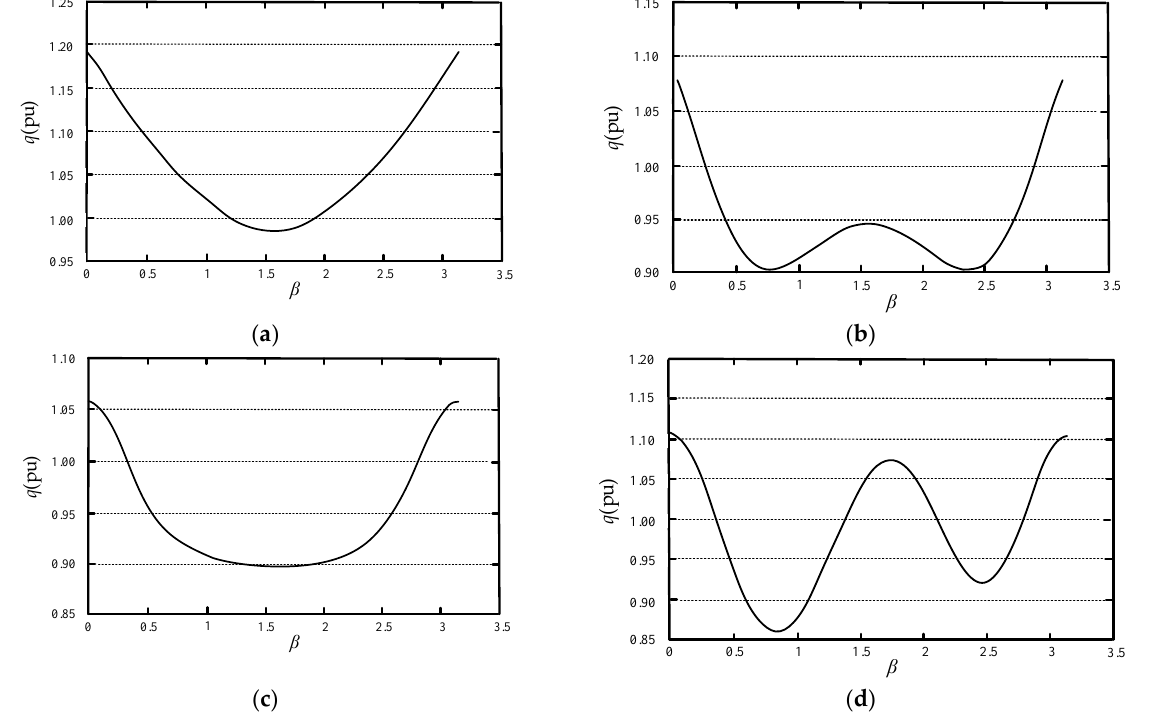
Figure 5. The relationship between q and β : ( a ) N = 2, L = 4 a ; ( b ) N = 2, L = 8 a ; ( c ) N = 3, L = 8 a ; ( d ) N = 4, L = 8 a .